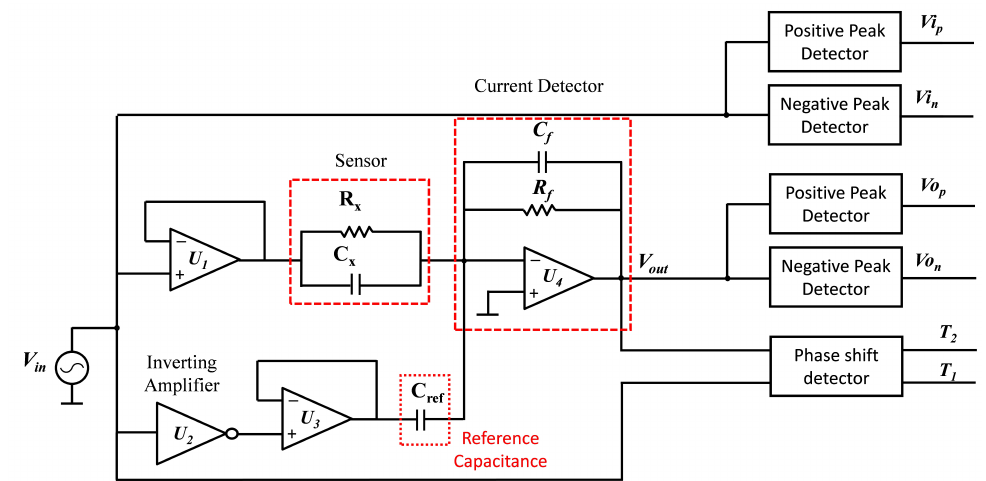
Figure 9. Impedance measurement circuit based on the conversion of impedance to voltage and phase